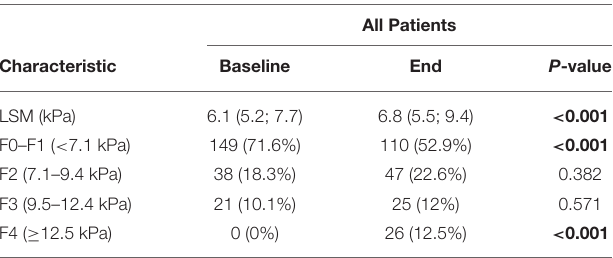
TABLE 3 | Clinical characteristics related to hepatic fibrosis in patients with chronic hepatitis C during the